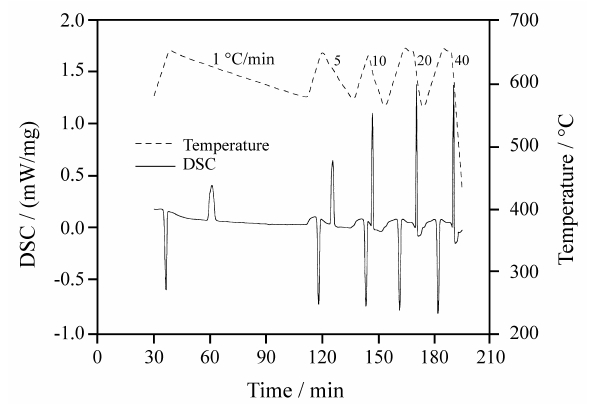
Figure 2. Typical heating and cooling cycles of an Sn-Se eutectic alloy obtained during a DSC